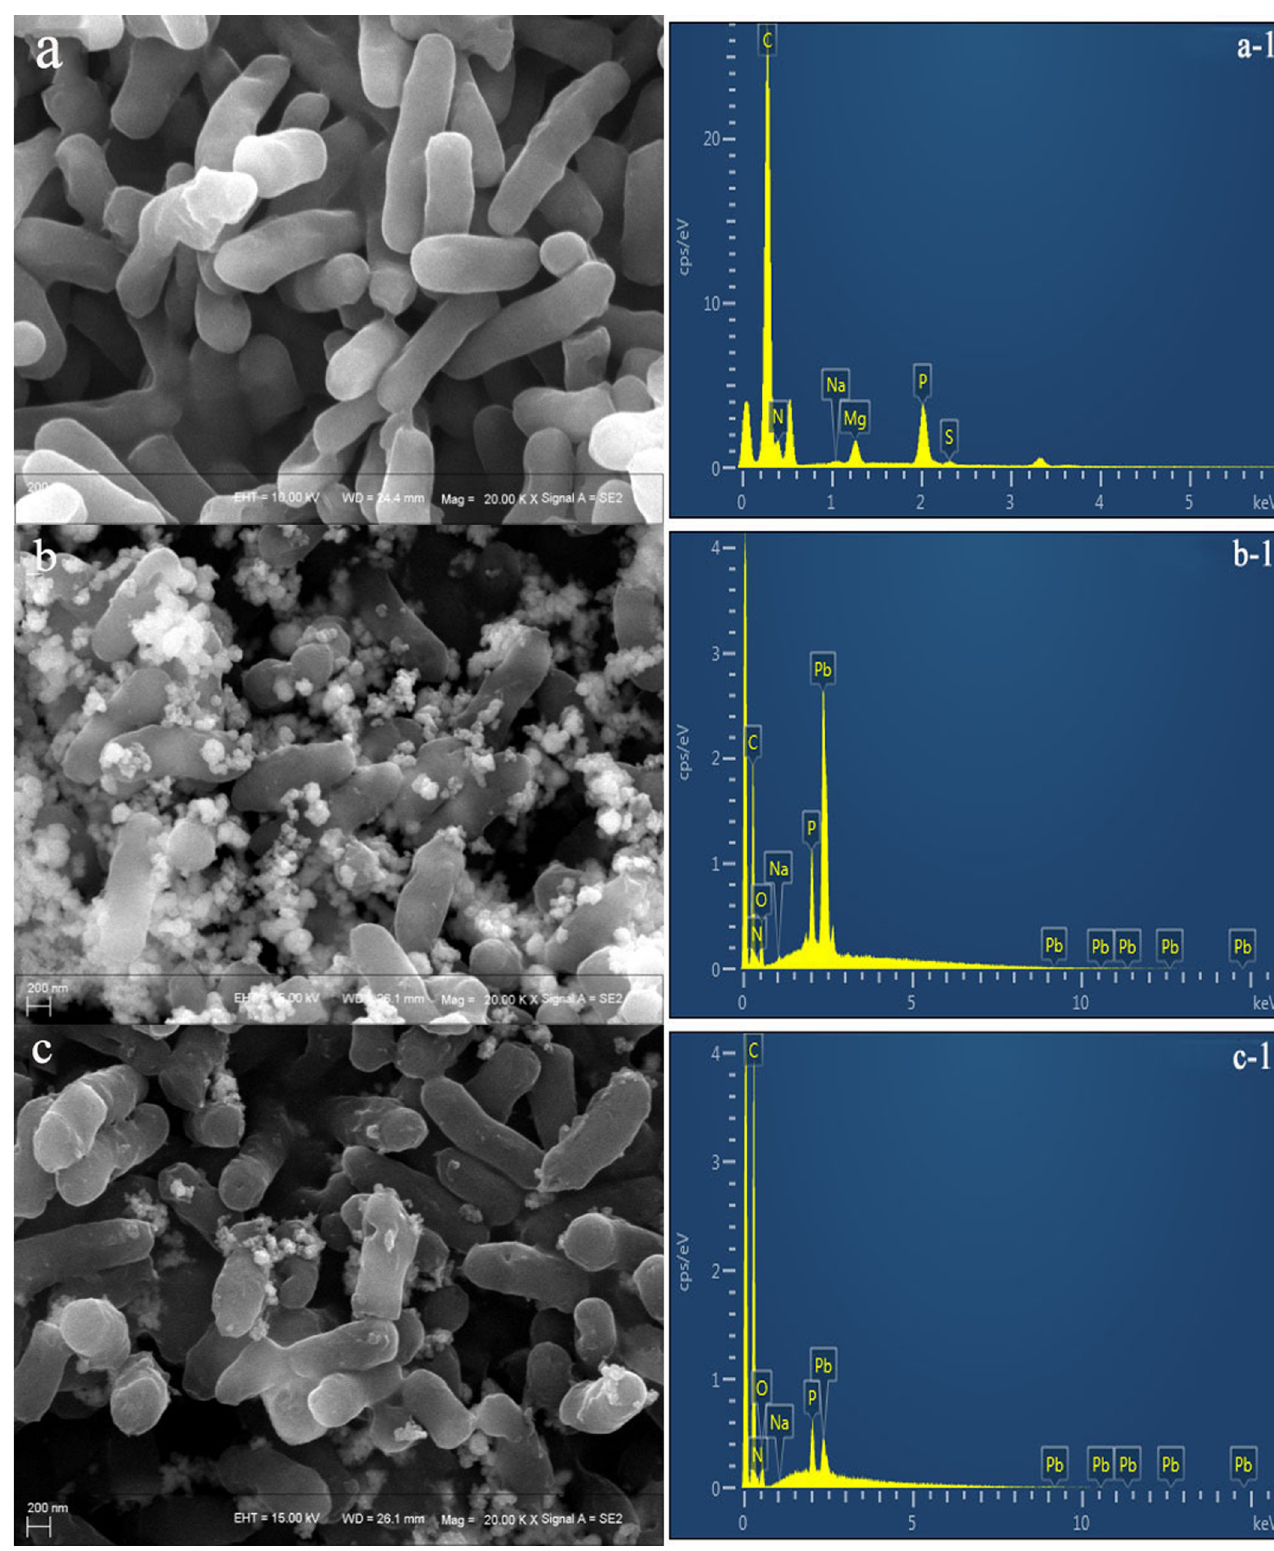
Fig 7. SEM image and EDX of biosorption Pb 2+ by live and dead biosorbents (a: Native live biosorbents; a-1: EDX for native live biosorbents; b: Pb 2+ loaded dead biosorbents; b-1: EDX for Pb 2+ loaded dead biosorbents; c: Pb 2+ loaded live biosorbents; c-1: EDX for Pb 2+ loaded live biosorbents; Pb 2+ : 200 mg L -1 ). https://doi.org/10.1371/journal.pone.0226557.g007 PLOS ONE | https://doi.org/10.1371/journal.pone.0226557 January 29,